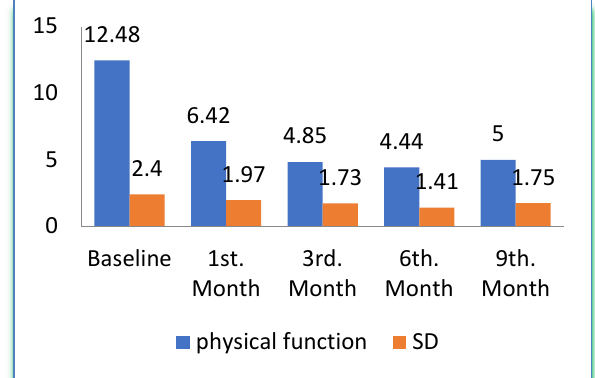
Figure 13.physical function scores with the corresponding